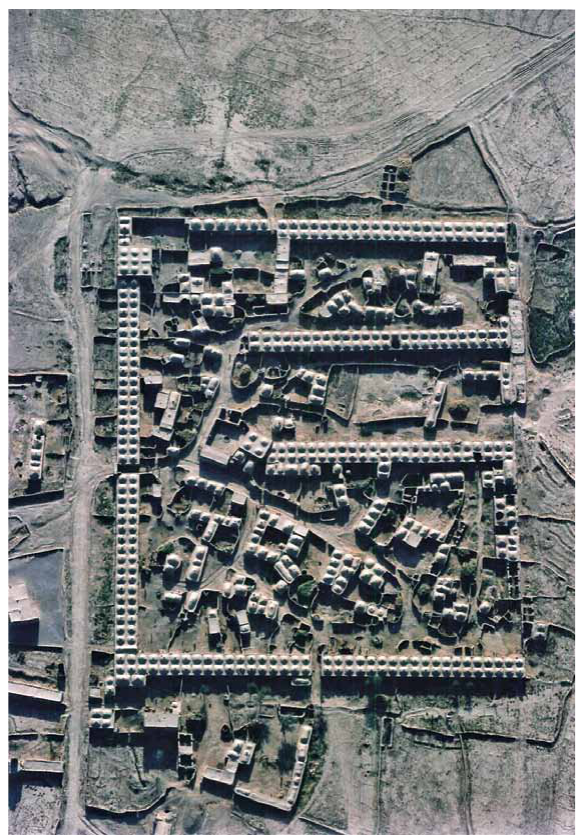
fig. 10. Inhabitable walls. aerial photo of a small city in Khorasan, Iran. Source : Gerster, G. 2008. Paradise lost: Persia from above. london: